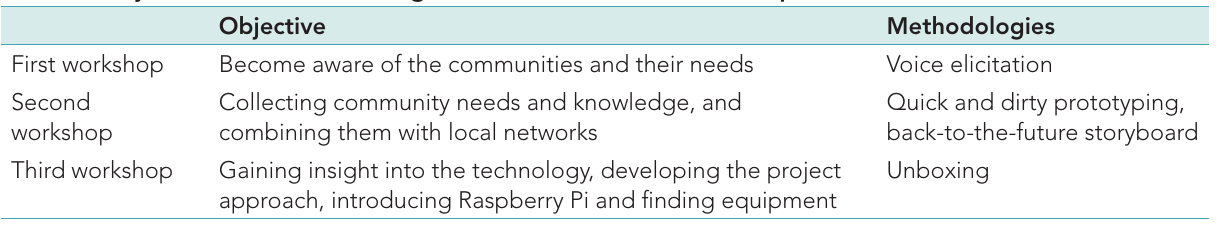
Table 2: Objectives and methodologies of the co-creation workshops (Source: Authors,